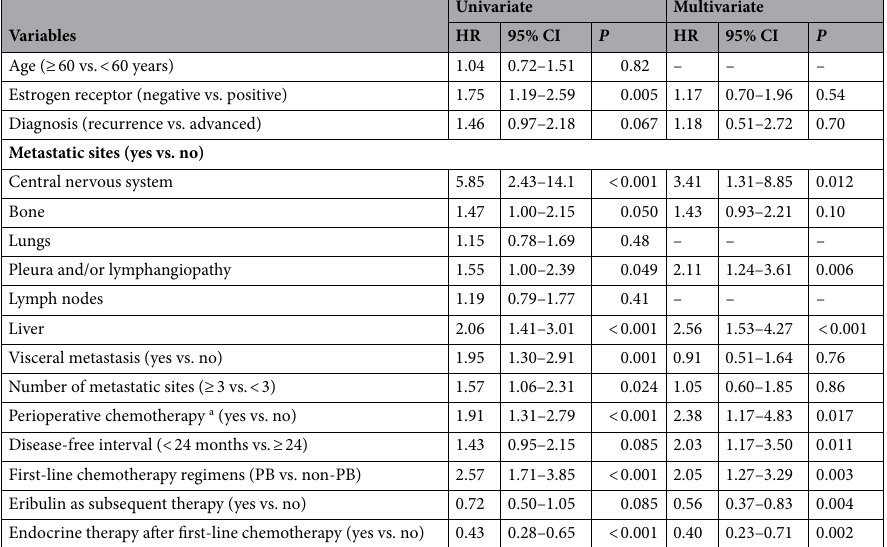
Table 3. Univariate and multivariate analyses of the overall survival in patients with the shorter time to treatment failure group (Cox hazard model). CI confidence interval, HR hazard ratio, PB paclitaxel plus bevacizumab.